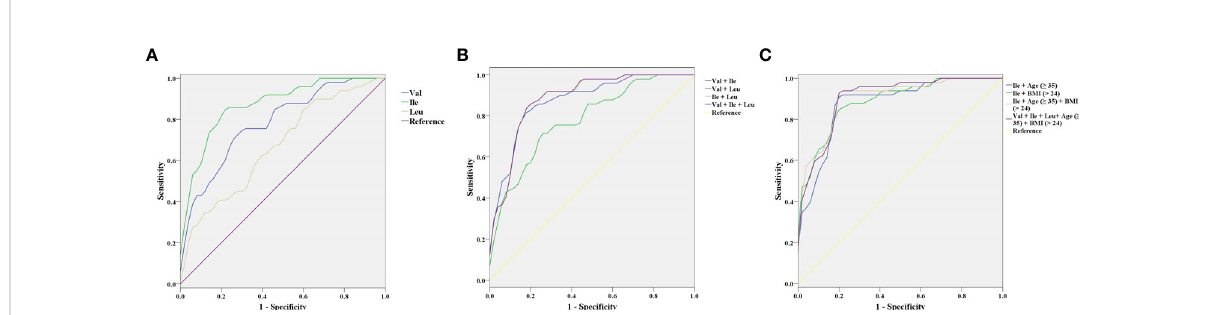
FIGURE 2 The receiver operating characteristic (ROC) curves of branched-chain amino acids (BCAAs) in the fi rst trimester for the prediction of gestational diabetes mellitus (GDM). (A) Valine (Val), Isoleucine (Ile), and Leucine (Leu). (B) Val + Ile, Val + Leu, Ile + Leu, and Val + Ile + Leu. (C) Ile + age ( ≥ 35), Ile + BMI ( ≥ 24), Ile + Age ( ≥ 35) + BMI ( ≥ 24), and Val + Ile + Leu+ Age ( ≥ 35) + BMI ( ≥